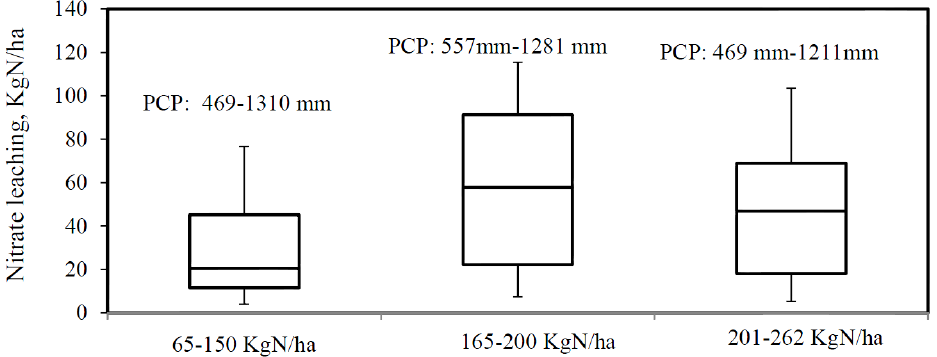
Figure 4. Subsurface nitrogen leaching from fine loamy soil for continuous corn at various ranges of precipitation (seven journal articles were used for analysis). PCP: Precipitation. Figure 5 indicates the annual subsurface nitrate loss from the silty loam for continuous corn.